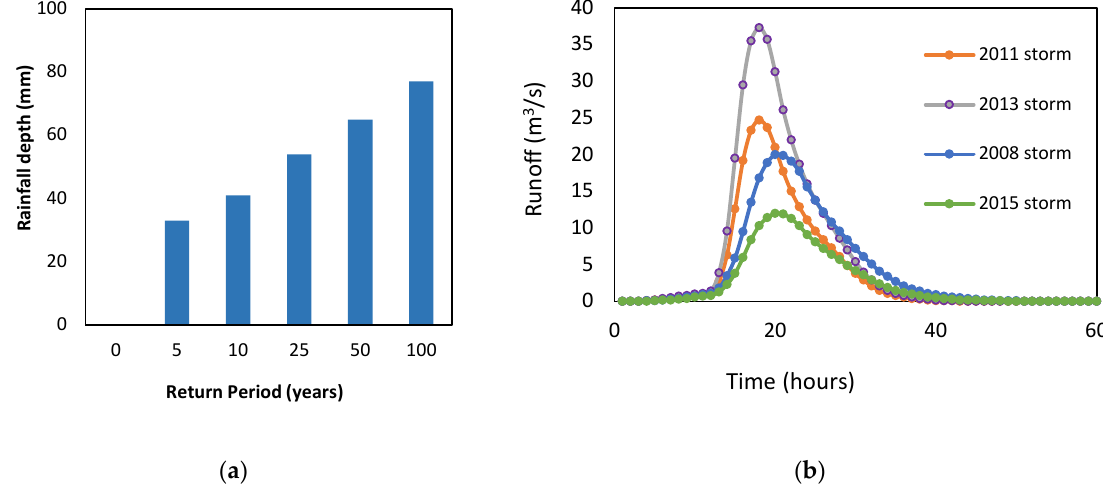
Figure 8. Depth duration graph and hydrographs obtained as a result of calibration and verification of hydrologic model, ( a ) depth duration graph; ( b ) hydrographs for rainfall events during 2008, 2011, 2013 and 2015.